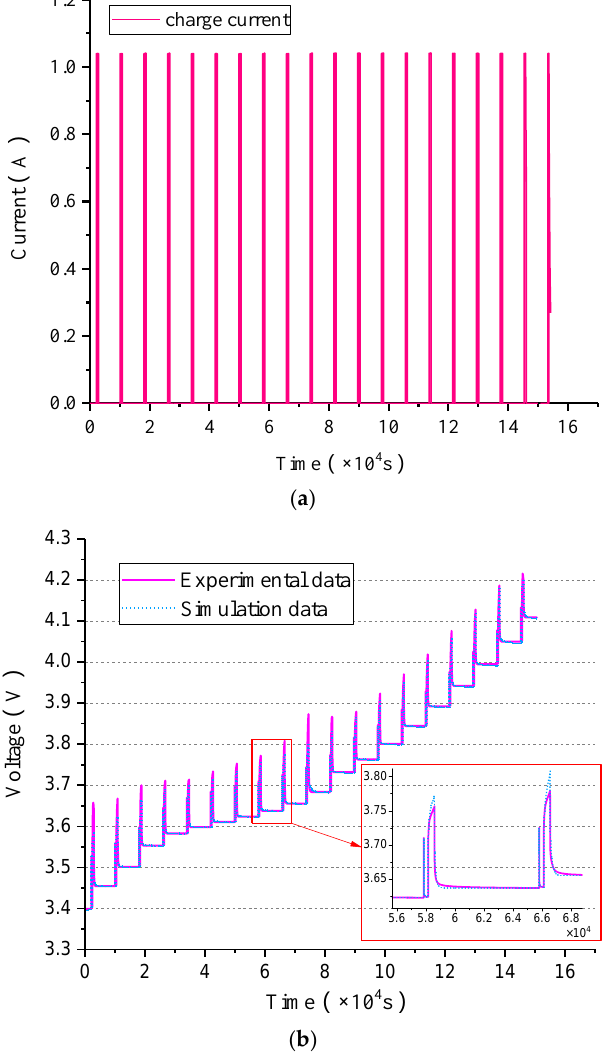
Figure 4. Simulation and test results with charging ratio of 0. 4C. ( a ) Charging current curve; ( b ) Voltage curves for simulation and testing.